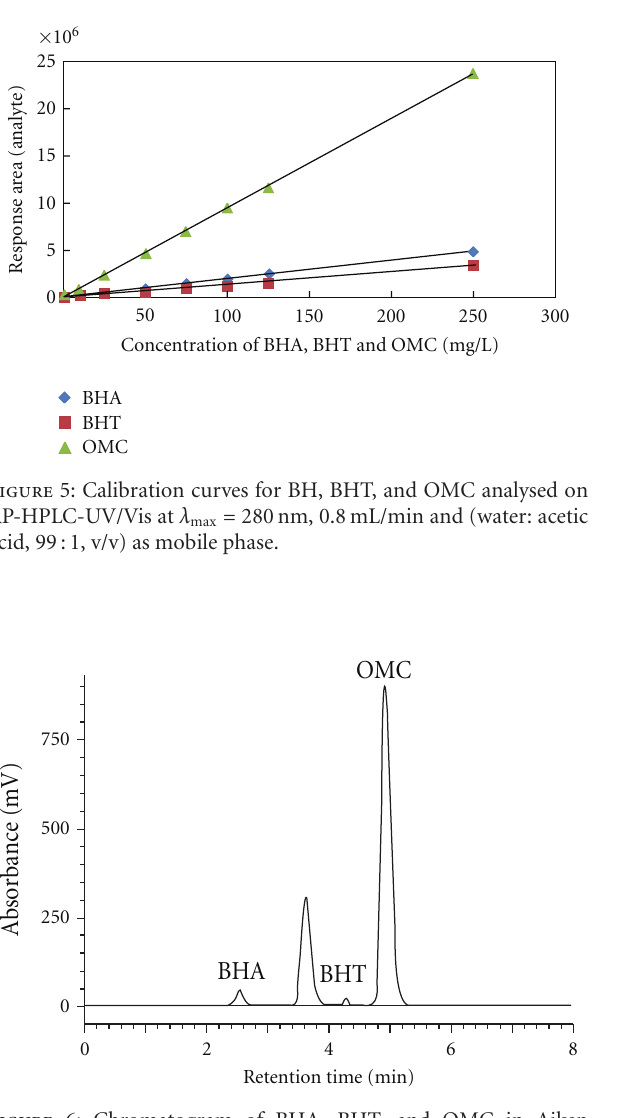
Figure 6: Chromatogram of BHA, BHT, and OMC in Aiken sunscreen cream sample using RP-HPLC-UV/Vis at λ max = 280 nm.